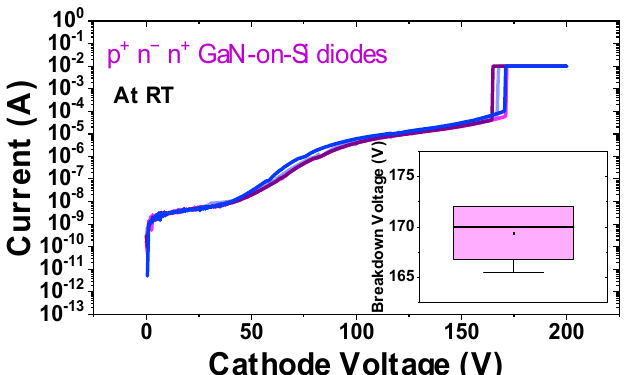
Figure 8. Reverse bias I–V diode characteristics until failure on four diodes. (inset) Mean breakdown voltage is 170 V.